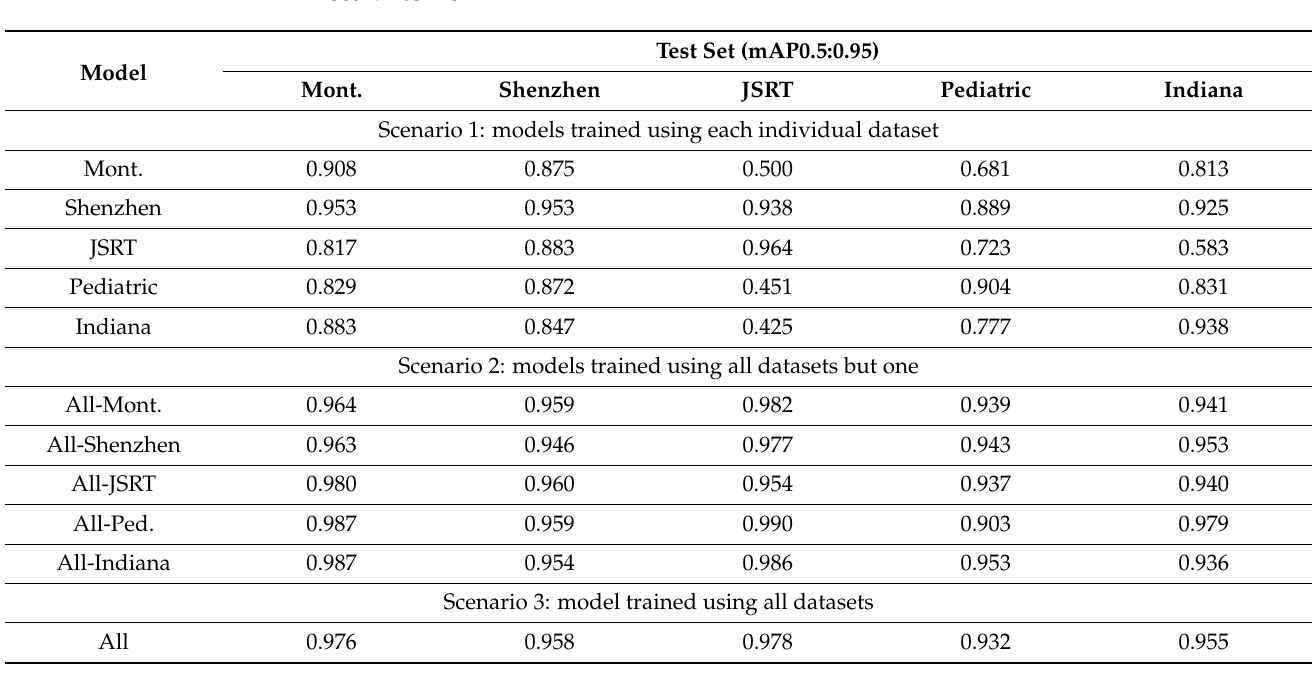
Table 3. The performance (mAP0.5:0.95) of models on the test set of each individual dataset for scenarios 1–3.